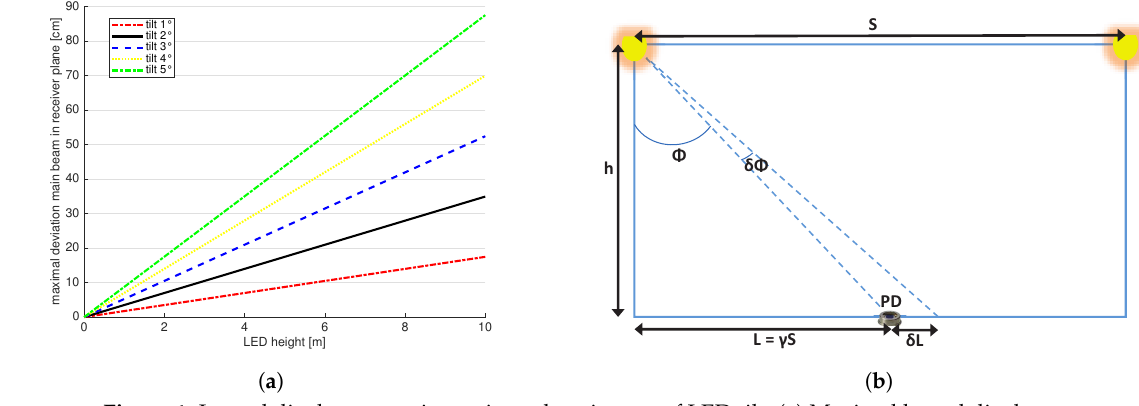
Figure 1. Lateral displacements in receiver plane in case of LED tilt. ( a ) Maximal lateral displacement of LED normal in the receiver plane due to LED tilt, as a function of LED-PD height difference; ( b ) Additional displacement ∂ L in receiver plane due to LED tilt ∂φ as a function of angle of irradiance φ ( S = square side length, h = LED-PD height